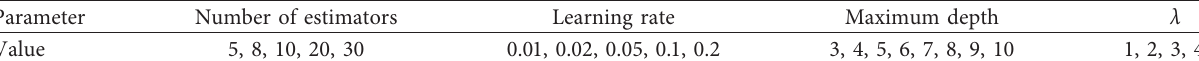
Table 8: The candidate values of four parameters for grid search algorithm.